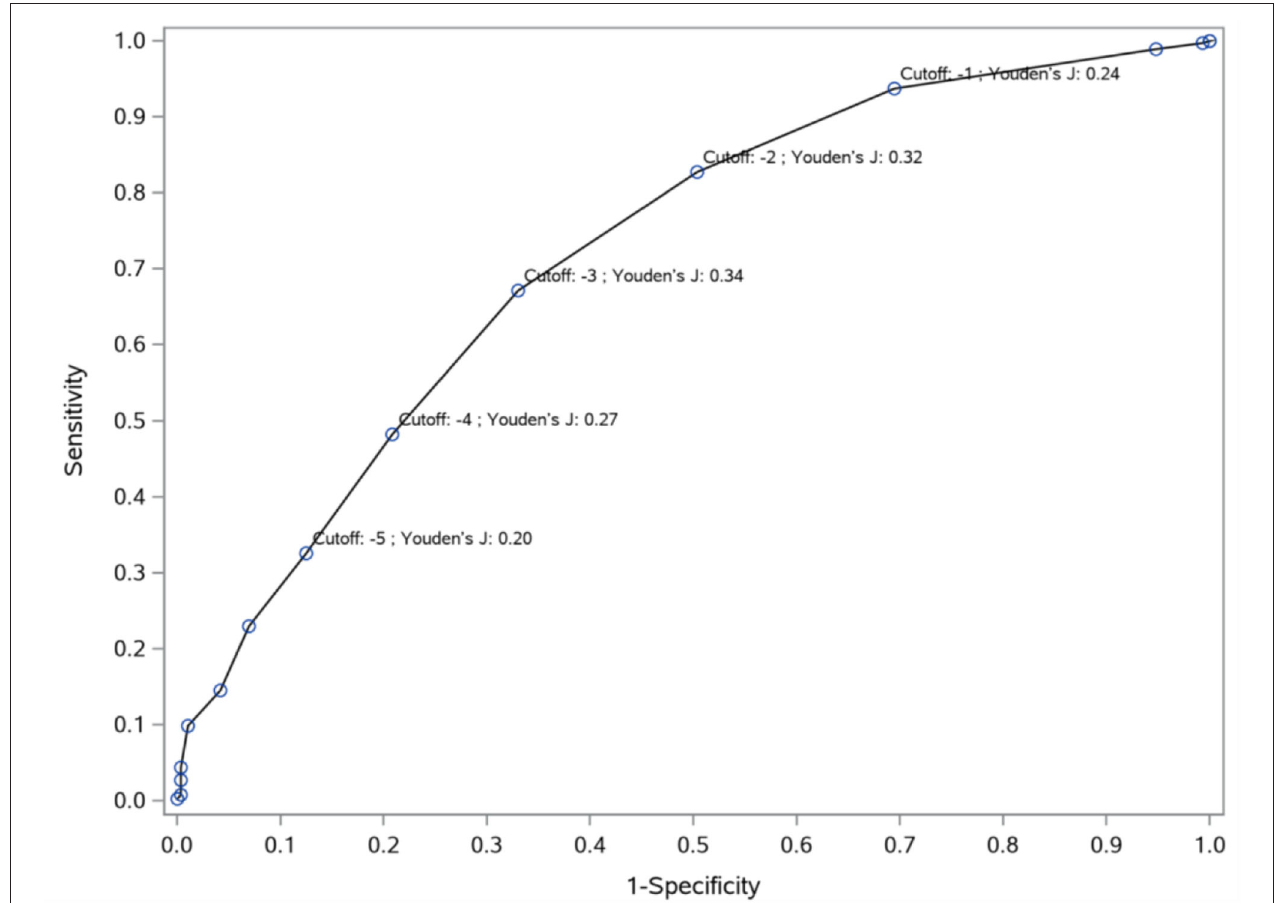
FIGURE 3 | Cut-off values (Youden’s indices) for predicting improvement from no clinical change to minimal improvement. To differentiate minimal improvement from no clinical change, Youden’s J indices were computed at different cut-off points based on the PANSS-FSNS change. The sensitivity (vertical axis) and 1- specificity (horizontal axis) values for the differentiation of minimal improvement from no clinical change are depicted in the figure for various values of change from baseline in the PANSS-FSNS (labeled as “Cutoff”). Please note that the Youden’s J index, which shows the efficiency of differentiation based on the combination of sensitivity and specificity, first increases then decreases with increasingly greater improvements (i.e., with greater negative values) as compared to baseline. The highest value of the Youden’s J Index is reached at the cut-off value of − 3 (i.e., at a 3 point reduction of symptom severity from baseline in the PANSS-FSNS), which identifies the optimal change value that maximizes sensitivity and specificity